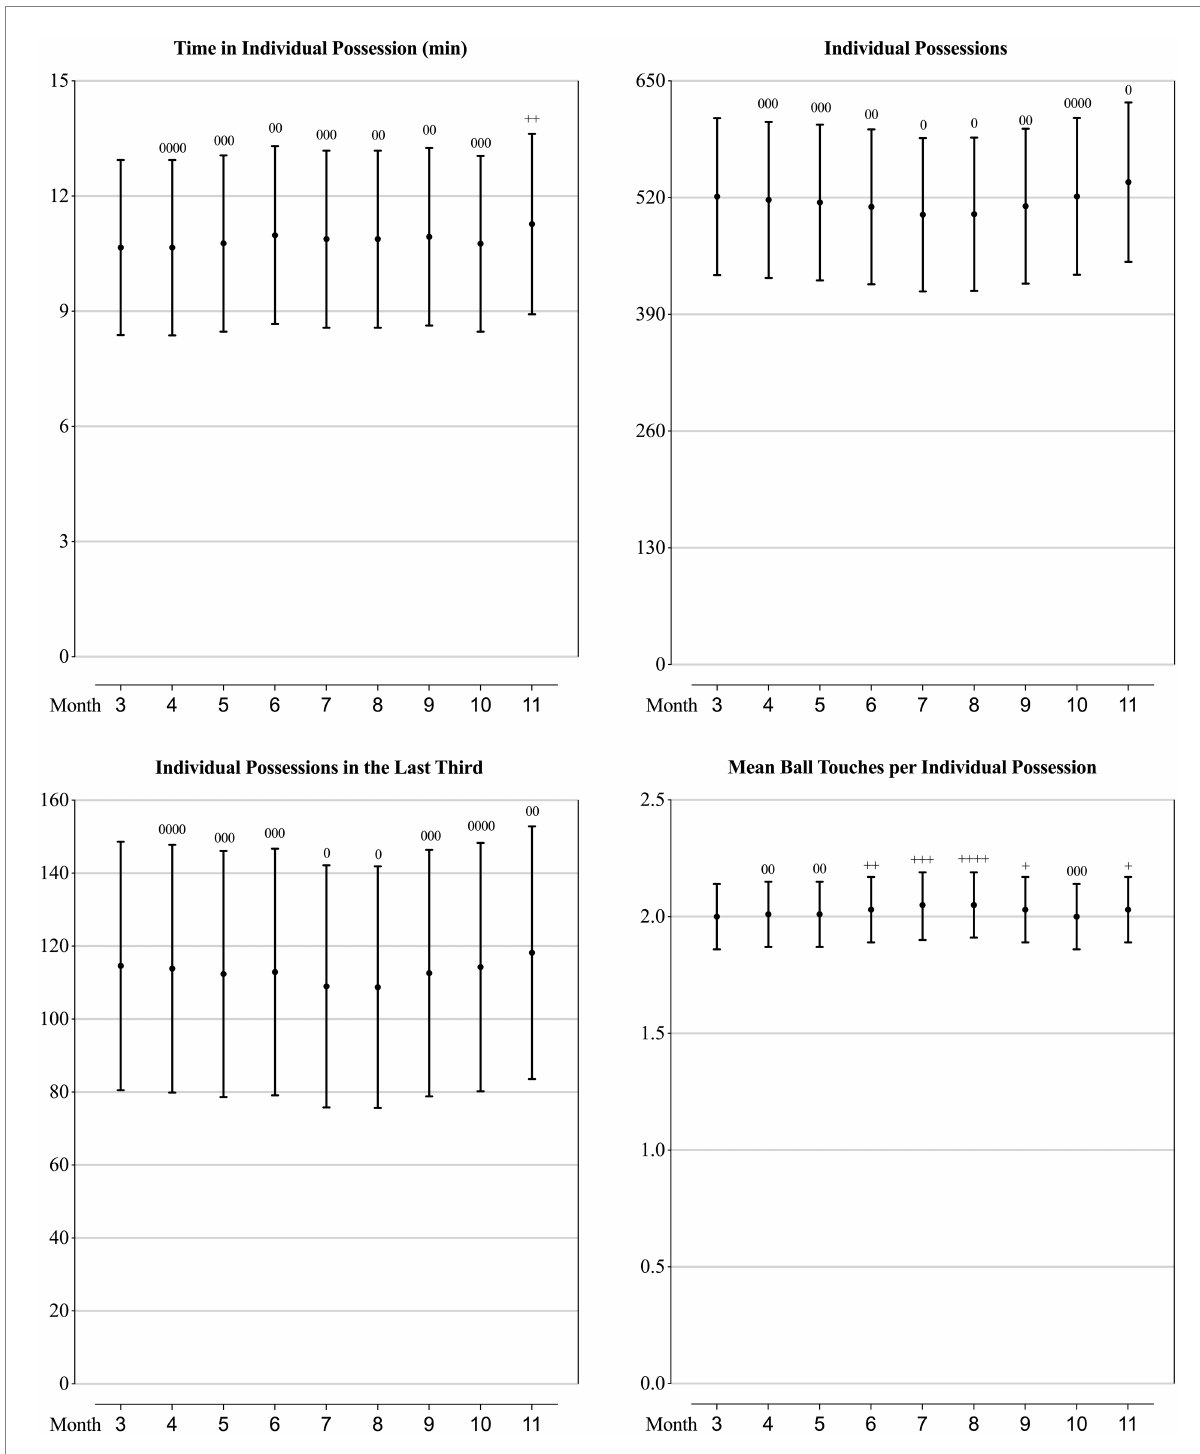
FIGURE 3 Values of ball possession-related parameters in each month of a season for the teams competing in the CSL in 2012-2019 estimated from the generalised mixed linear modelling. Filled dots are the means. Error bars are the standard deviations. Symbols “0” and “+” stands for trivial and positive change from the value of March (month “3”). Number of symbols indicate the likelihood for the magnitude of the true effect as follows: 1-possible; 2-likely; 3-very likely; 4-most